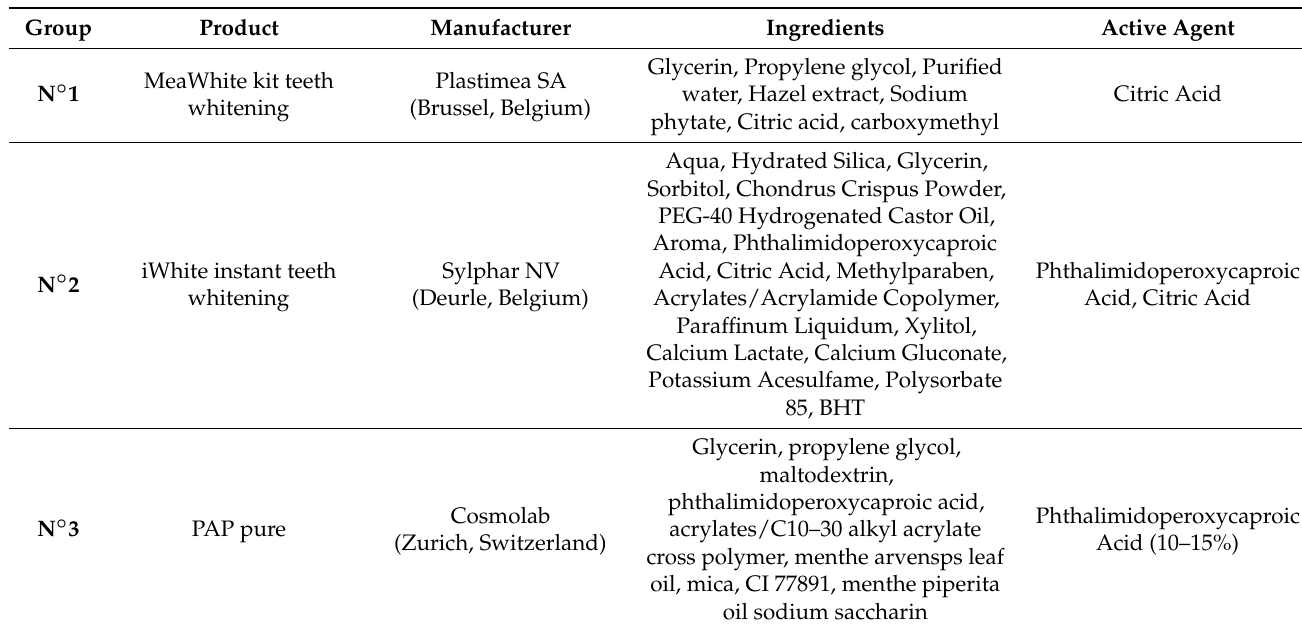
Table 2. Details of bleaching